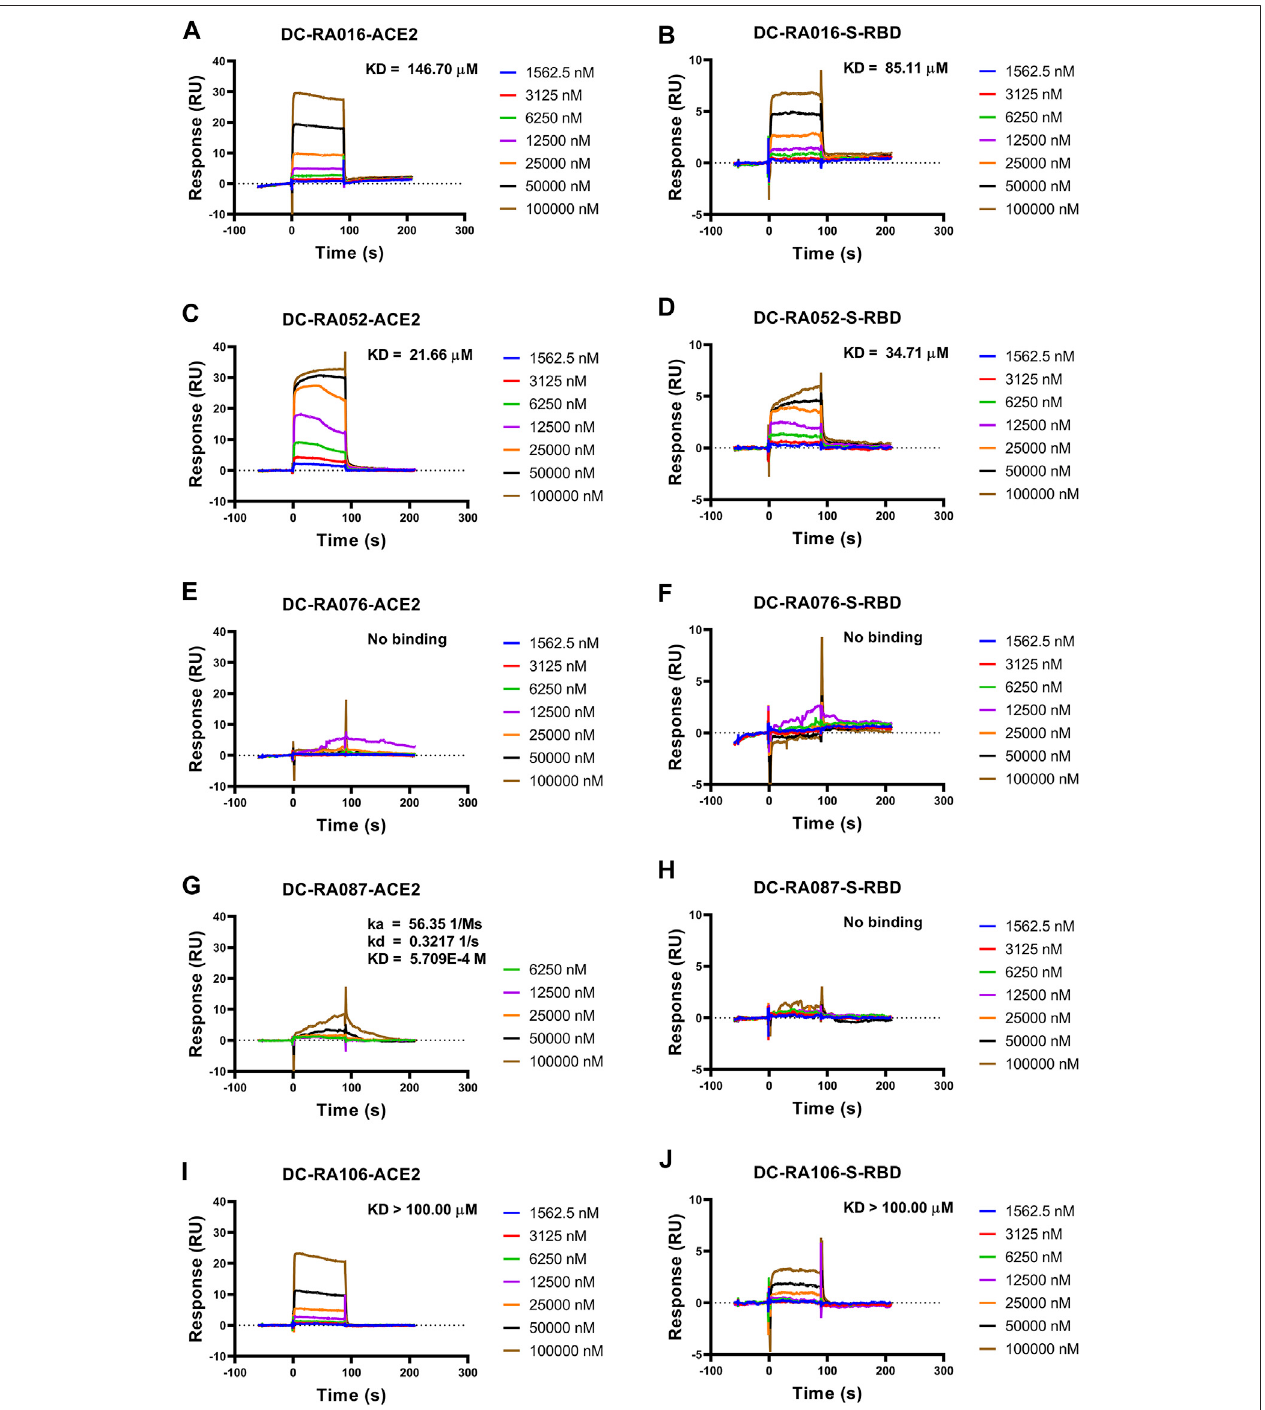
FIGURE5| Thebindingaf fi nitybetweenthe fi vecompoundsandSARS-CoV-2S-RBDorACE2.CompoundsboundtoSARS-CoV-2S-RBDorACE2.Interactions of SARS-CoV-2 S-RBD or ACE2 with compounds measured by SPR. The SARS-CoV-2 S-RBD or ACE2 was coated on the CM5 sensor chip and serial dilutions of compounds(typically, 1,562.5,3,125,6,250,12,500,25,000,50,000and100,000 nM)wereusedasanalytes.Changesinplasmon resonanceareshown asresponse units. (A) Binding curves (colored lines) obtained by passing different concentrations of DC-RA016 over immobilized ACE2. (B) Binding curves (colored lines) obtained by passing different concentrations of DC-RA016 over immobilized S-RBD. (C) Binding curves (colored lines) obtained by passing different concentrations of DC-RA052 over immobilized ACE2. (D) Binding curves (colored lines) obtained by passing different concentrations of DC-RA052 over immobilized S-RBD. (E) Binding curves(colored lines)obtainedbypassingdifferentconcentrationsofDC-RA076 overimmobilized ACE2. (F) Bindingcurves (coloredlines)obtainedbypassingdifferent